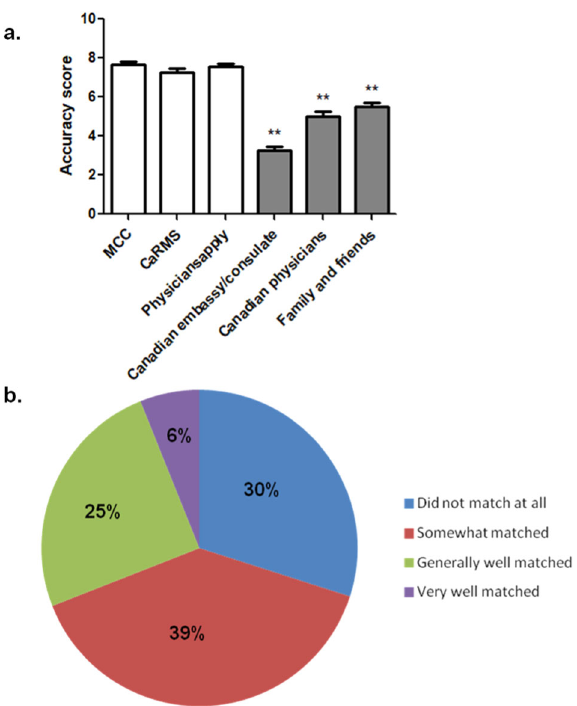
Fig. 1 Accuracy of information available at the early career planning stage. ** P < 0.01. a Acurracy of different resources. Scores were provided on a scale from 1 (the least accurate) to 10 (the most accurate). One-way ANOVA and non-parametric t -test showed signi fi cantly lower scores received by the Canadian embassy/consulate, Canadian physicians, and family and friends compared to each of the top three choices (MCC, CaRMS, Physiciansapply). Error bars indicate the standard error of the mean (SEM). b match between information received at the early career planning stage and the career reality in